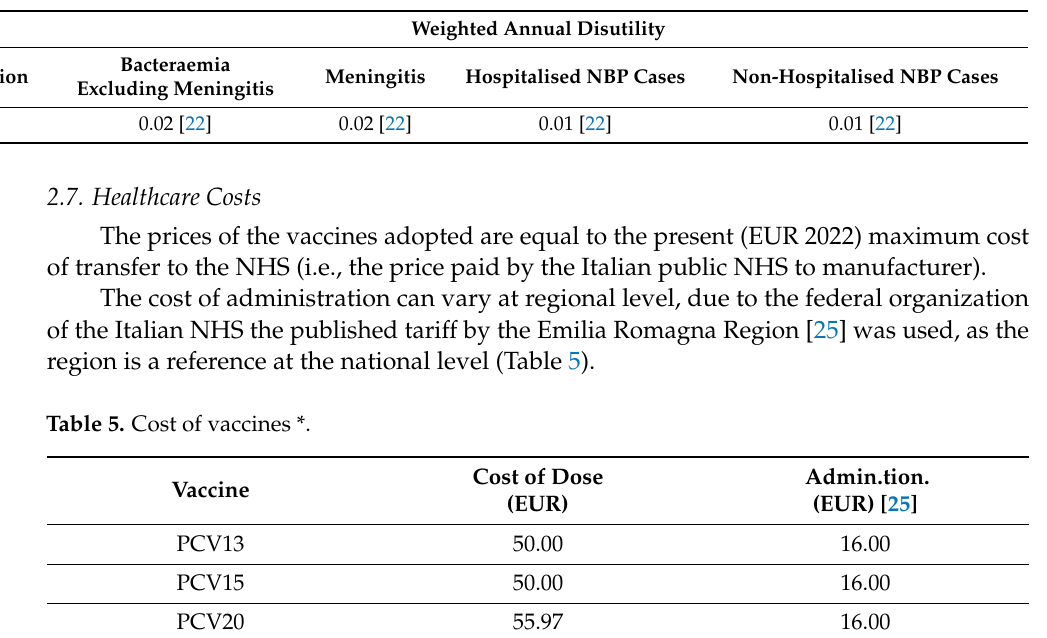
Table 4. Quality of life (HRQoL).